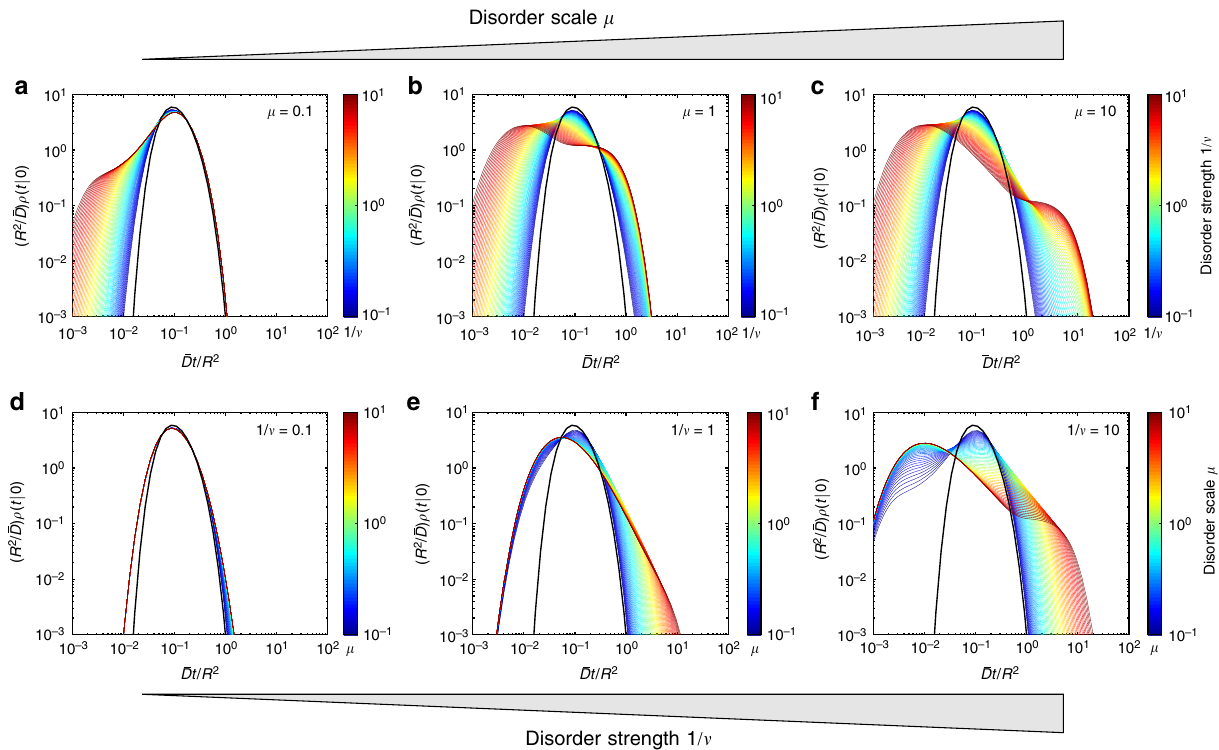
Fig. 2 The impact of dynamic disorder onto the distribution of fi rst-passage times. The probability density function ρ ( t |0) of the fi rst-passage time from the center to the perfectly reactive boundary of a ball of radius R is shown by colored curves for various combinations of dimensionless parameters ( μ , 1/ ν ) characterizing the disorder scale and strength: μ = στ / R and 1 = ν ¼ τσ 2 = (cid:1) D . Thick black curve presents ρ hom ( t |0) for homogeneous diffusion with diffusivity (cid:1) D . a – c Three values of the disorder scale μ (0.1 ( a ); 1 ( b ); and 10 ( c )) and 64 values of the disorder strength 1/ ν in the logarithmic range between 10 − 1 and 10 1 . d – f Three values of the disorder strength 1/ ν (0.1 ( d ); 1 ( e ); and 10 ( f )) and 64 values of the disorder scale μ in the logarithmic range between 10 − 1 and 10 1 . Curves encoded by color, ranging from dark blue (10 − 1 ) to dark red (10 1 ), as shown by